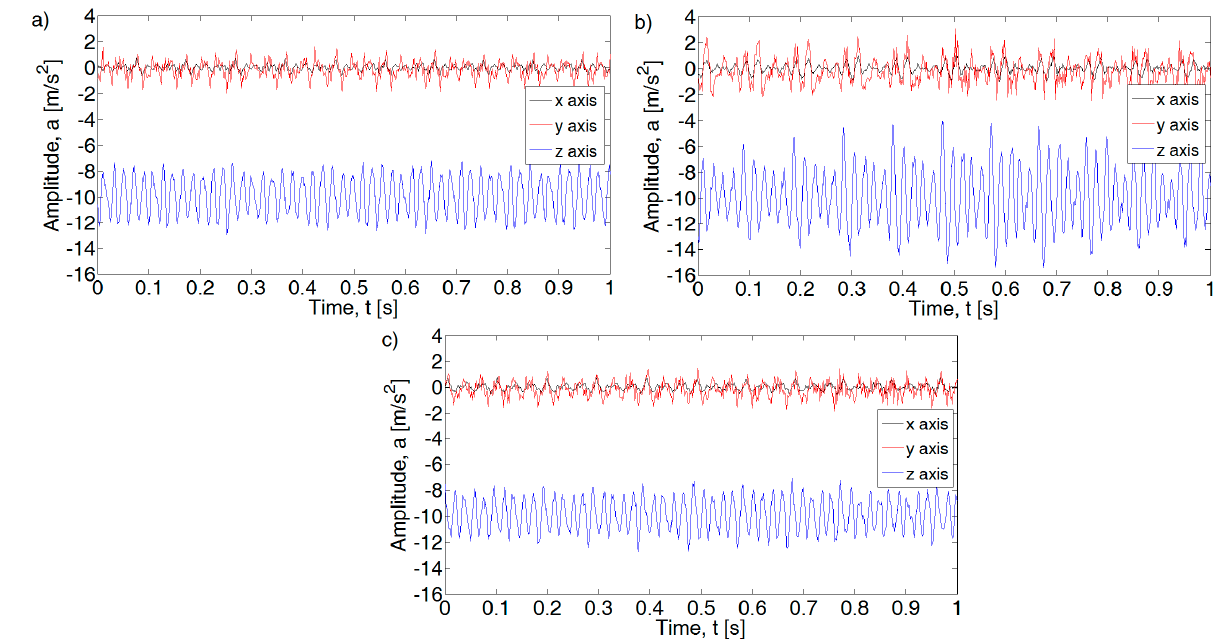
Figure 3. Example of acceleration sensor signal for a low-speed engine .